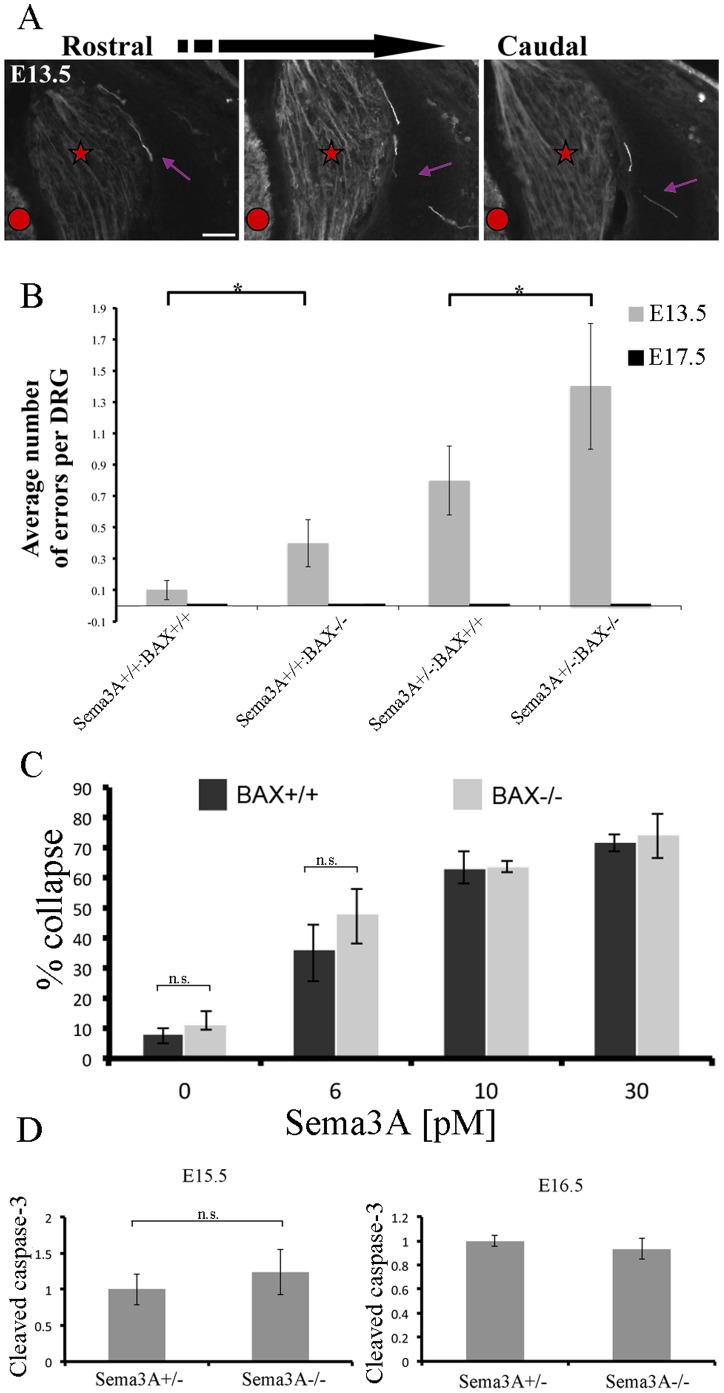
Increased levels of axon guidance errors in BAX null and heterozygote Sema3A:BAX null mice.
A: Representative image of errors observed in DRG from Sema3A+/+:BAX−/− mice. Three adjacent cross sections of E13.5 DRG are shown. Most of the observed errors in the indicated genotypes were single axons or small bundles. Note the tortuous path an abnormal axon takes in and out of the plane of view. Scale bar 50 µm. B: Analysis of error occurrence in the indicated genotypes at E13.5. Increase in error frequency is detected in BAX null background, indicating cell-death involvement in both wild-type and Sem3A+/− mice (n = 30 DRG per genotype (Wild type versus Sema3A+/+:BAX−/− P = 0.0416, Sema3A+/− :BAX+/+ versus Sema3A+/−:BAX−/− P = 0.0006). C: DRG neurons from BAX−/− and BAX+/+ mice are equally responsive to Sema3A-induced growth cone collapse. DRG explants from E12.5 embryos (BAX+/+ and BAX−/− littermates) were cultured in the presence of 10 ng/ml NGF for 20 h, at which time neurons were treated with 0, 6, 7.5, 10, 15 or 30 pM Sema3A. After an additional incubation period of 40 min with or without Sema3A, the explants were fixed and stained with rhodamine phalloidin. Quantification of the growth cone collapse results is shown. Results represent the mean +/− S.E.M. of three independent experiments. None of the Sema3A concentrations induced statistically significant difference in collapse levels between BAX+/+ and BAX−/− groups, P>0.05. D: Activation of caspase-3 is not significantly changed in Sema3A null mice. For each embryo proteins were extracted from E15.5 (upper panel) and E16.5 (lower panel) DRGs from lumbar and thoracic levels (at least three embryos of each genotype were used). Relative changes in caspase-3 activation levels were measured by western blot analysis using an activated caspase-3-specific antibody (Cell Signaling Technology). To determine protein levels each membrane was re-blotted for actin. Quantification of band intensity was obtained using scanning densitometry (Quantity One, BioRad) of three blots representing three different experiments. Results were normalized to actin. The average normalized result of the wild-type embryos at each age was defined as 1. At E15.5 the difference between Sema3A null mice and wild-type littermates is not statistically significant (P>0.05).